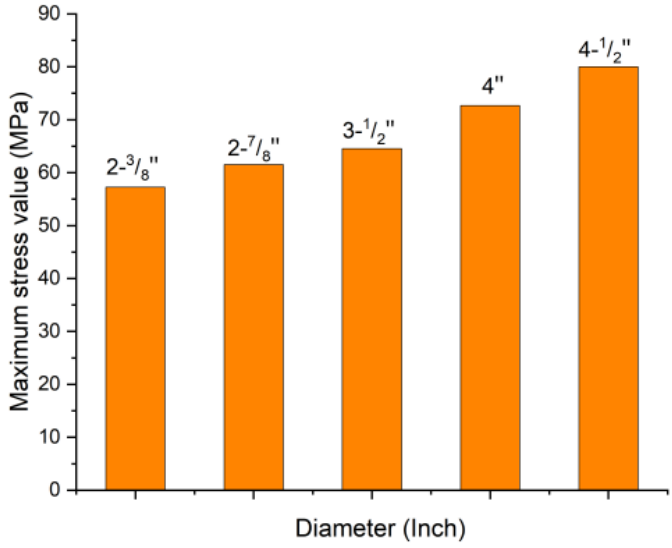
Figure 12. Maximum value of additional axial stress for different tubing diameters. (Uniform pump shutdown time of 6 s and inside pressure of 10 MPa). Figure 11. Dangerous resonance position of tubing under different pump shutdown times.